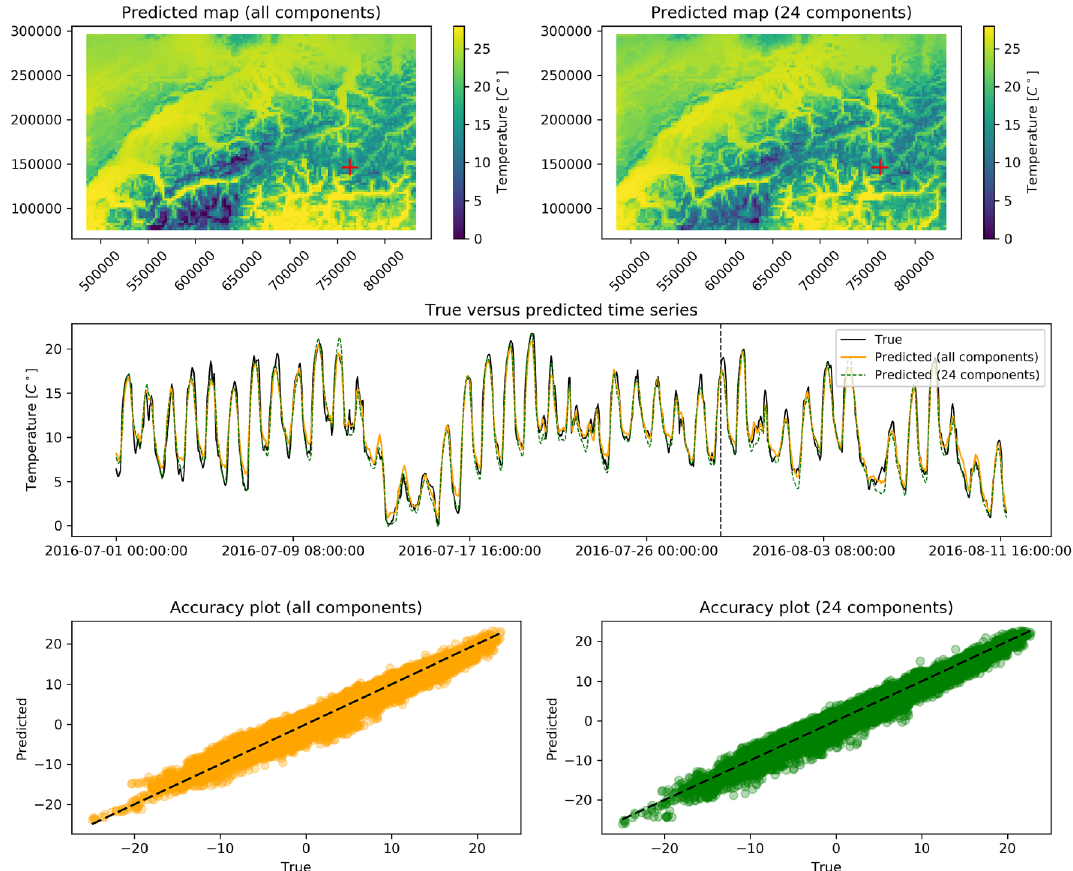
Figure 7. Model outputs for the temperature monitoring network. Top left : The predicted map of temperatures using all EOFs components, at the fixed time indicated by the vertical dashed line in the temporal plot below. Top right : The predicted map using only the first 24 components at the same time. Center : The true time series (in black) at a testing station marked by a cross in the maps above, the predicted time series with all EOFs components (in orange) and the predicted time series with the first 24 EOFs components (in green). For visualization purposes, only the first 42 days of the time series are shown. Bottom left: Accuracy plot at the testing station for the model with all EOFs components. Bottom right: Accuracy plot at the testing station for the model with the first 24 EOFs